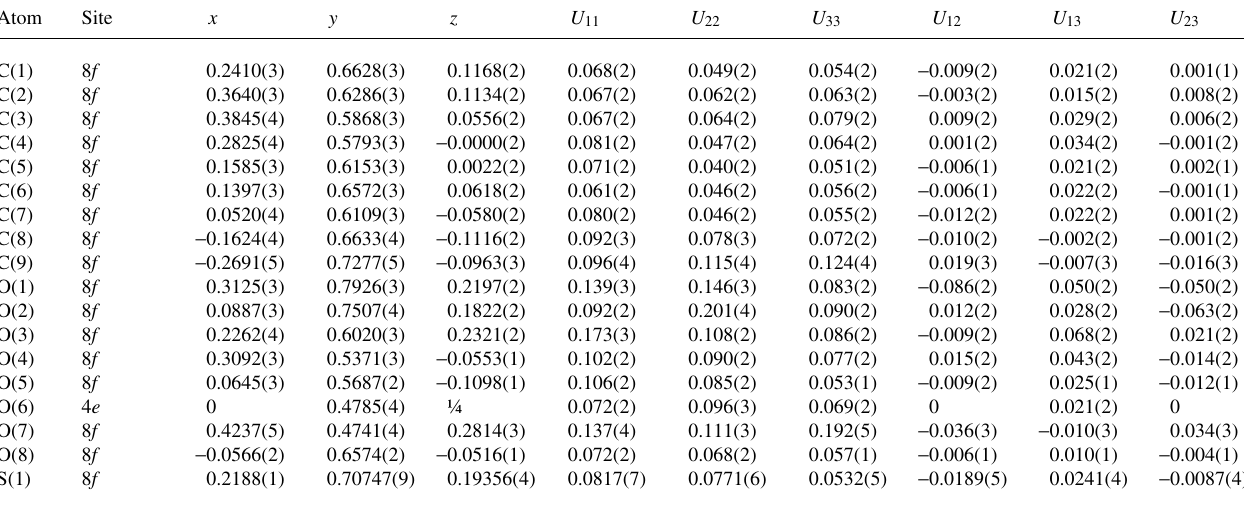
Table 3. Atomic coordinates and displacement parameters (in Å 2 )